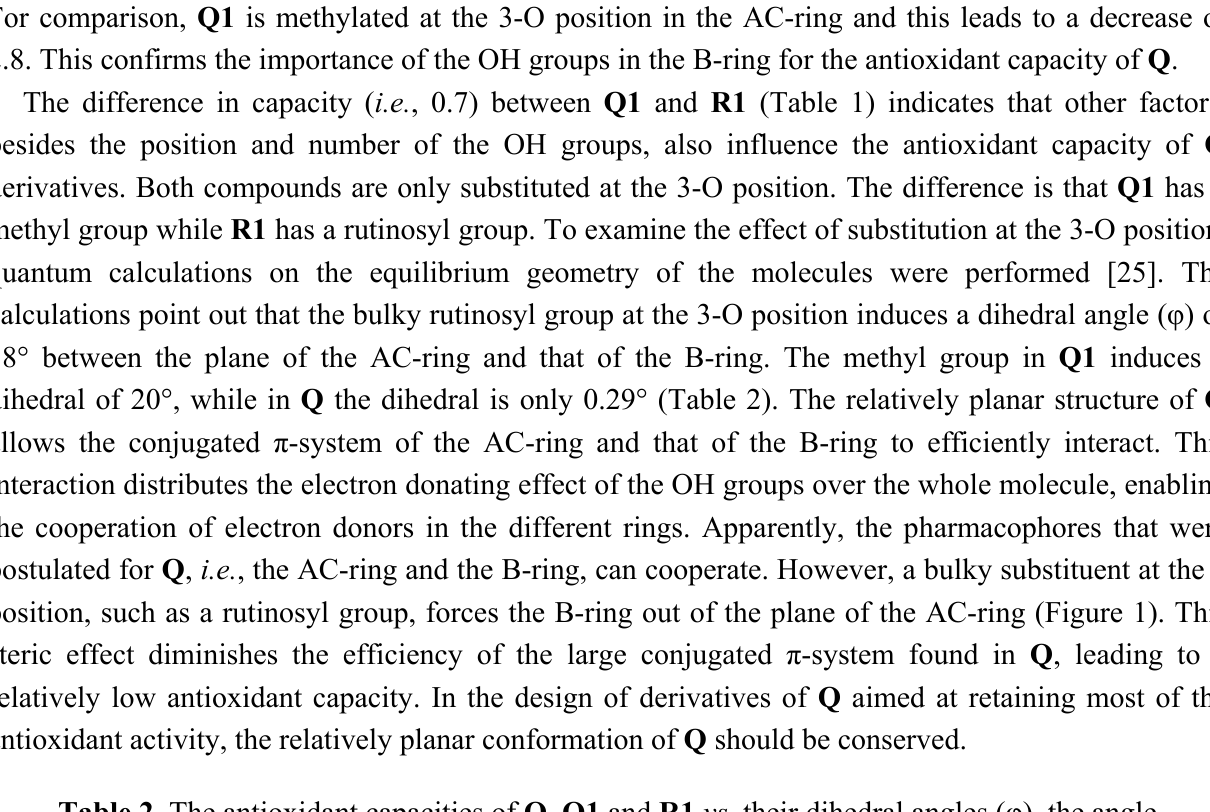
Table 2. The antioxidant capacities of Q , Q1 and R1 vs. their dihedral angles ( φ ), the angle between the plane of the AC-ring and that of the